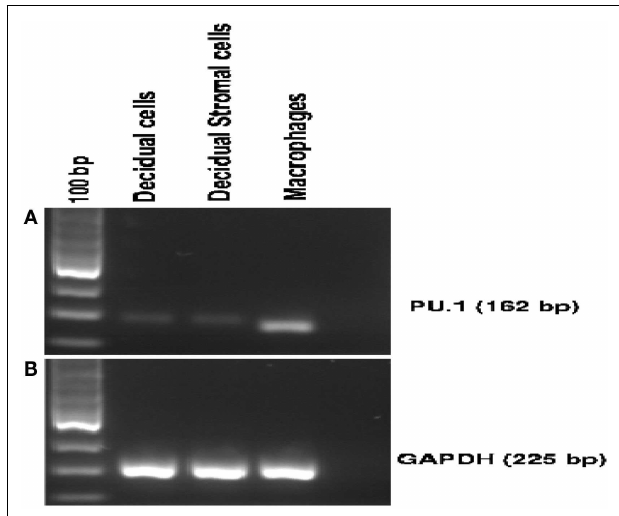
FIGURE 2 | Expression of PU.1 transcription factor by human first trimester decidua . Decidual cells and decidual stromal cells isolated from human decidua were analyzed for PU.1 (162bp) expression. For RT-PCR, 1 µ g of total RNA isolated from decidual cells, decidual stromal cells, and human macrophages was used as a template. PU.1 cDNA from decidual cells, decidual stromal cells, and human macrophages were amplified using specific primer set mentioned in Section “Materials and Methods” (A) . GAPDH was amplified to serve as an internal control (B) . Human macrophage cells served as a positive control (A) . All four decidual samples were positive for PU.1 expression.